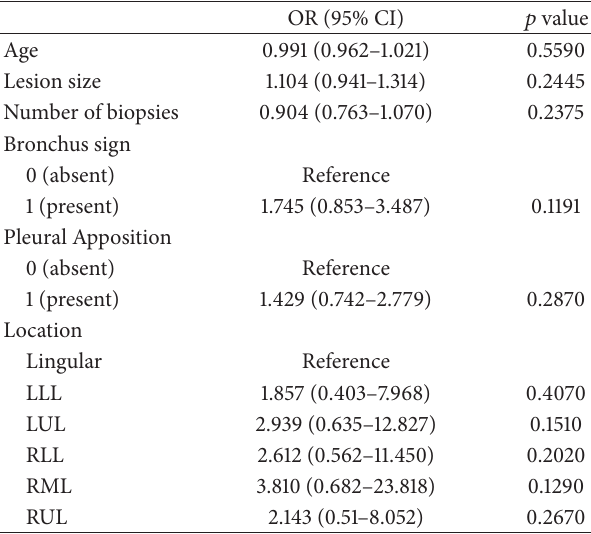
Table 4: Univariable logistic regression in predicting successful diagnosis of cancer or infection via bronchoscopy.